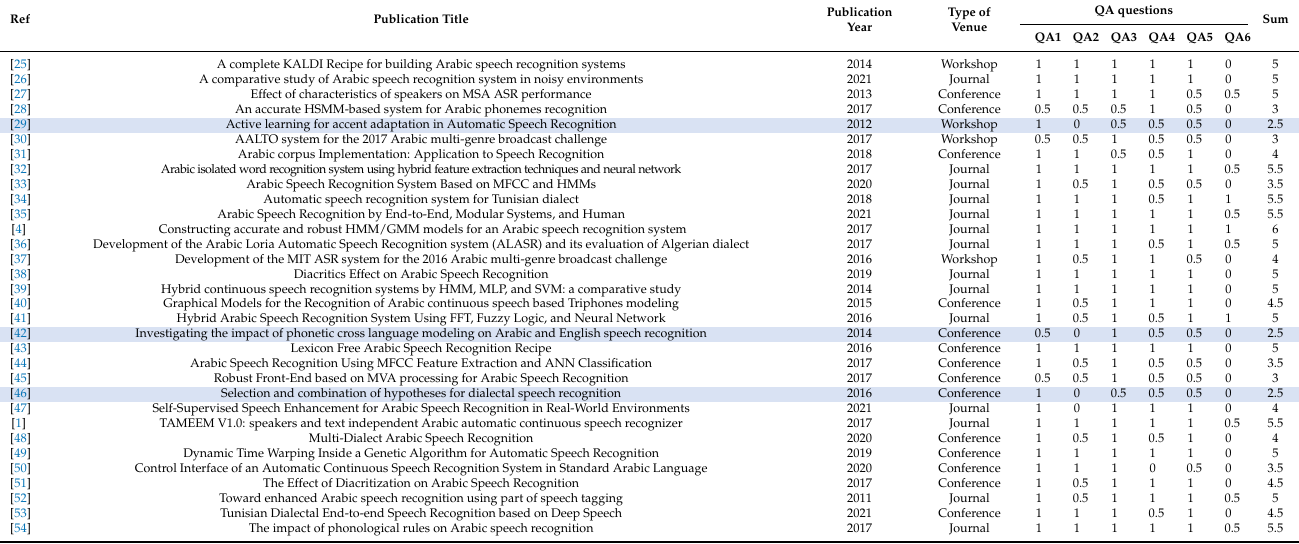
Table 5. Quality assessment of the candidate papers for inclusion and their